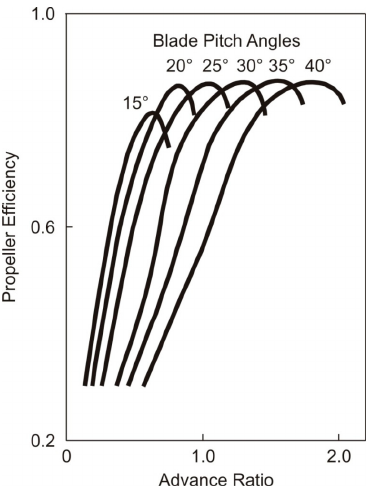
Figure 6. Propeller efficiency for a light aircraft (reproduced from [24], Piper Cherokee Arrow PA-28R).